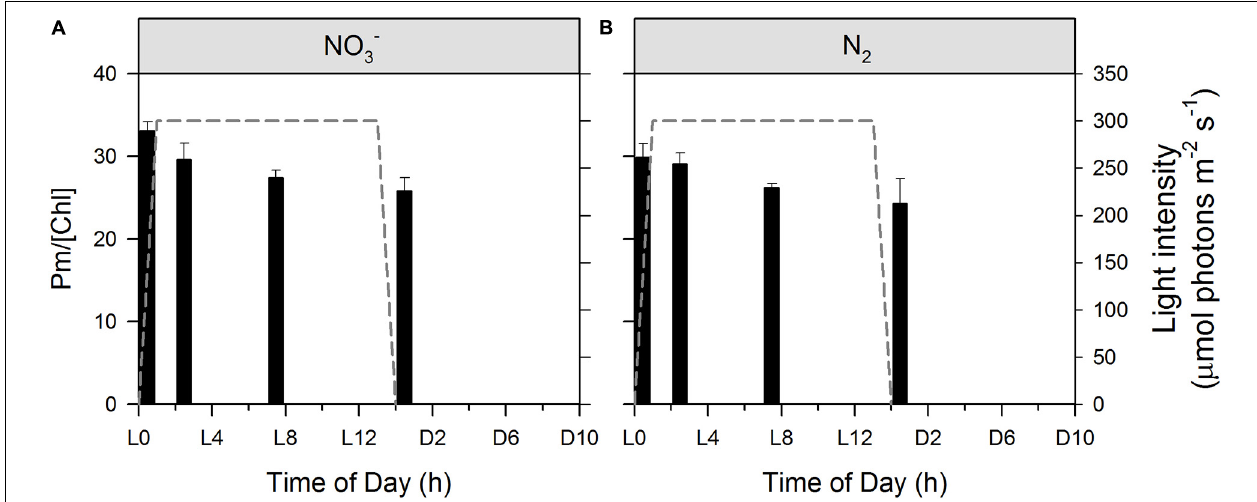
FIGURE 5 | Dynamics of relative PSI abundance during Cyanothece cultivation in ASP 2 medium supplemented with NO 3 − (A) and under obligate diazotrophy (B) . Maximal P 700 levels (Pm), which is proportional to PSI abundance was normalized to corresponding Chl a concentrations. Data represent averages from 3 replicates, with error bars representing standard deviations. An ANOVA with post hoc Tukey HSD test points to i/a significant difference between L0 and L14 samples in both cultures and ii/no significant difference between